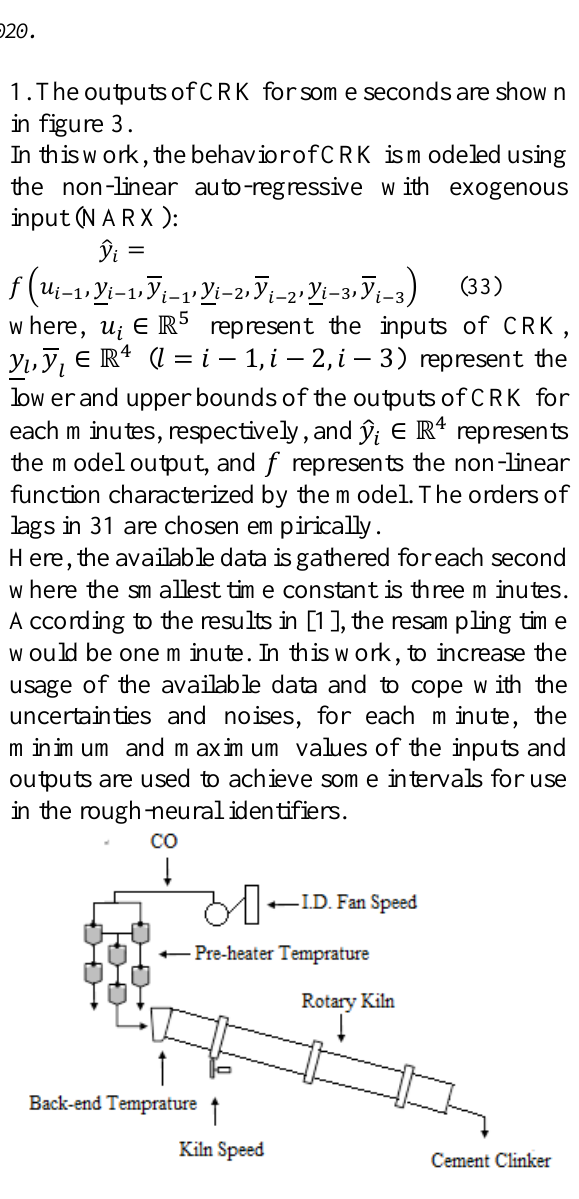
Figure 2. Schematic representation of CRK.